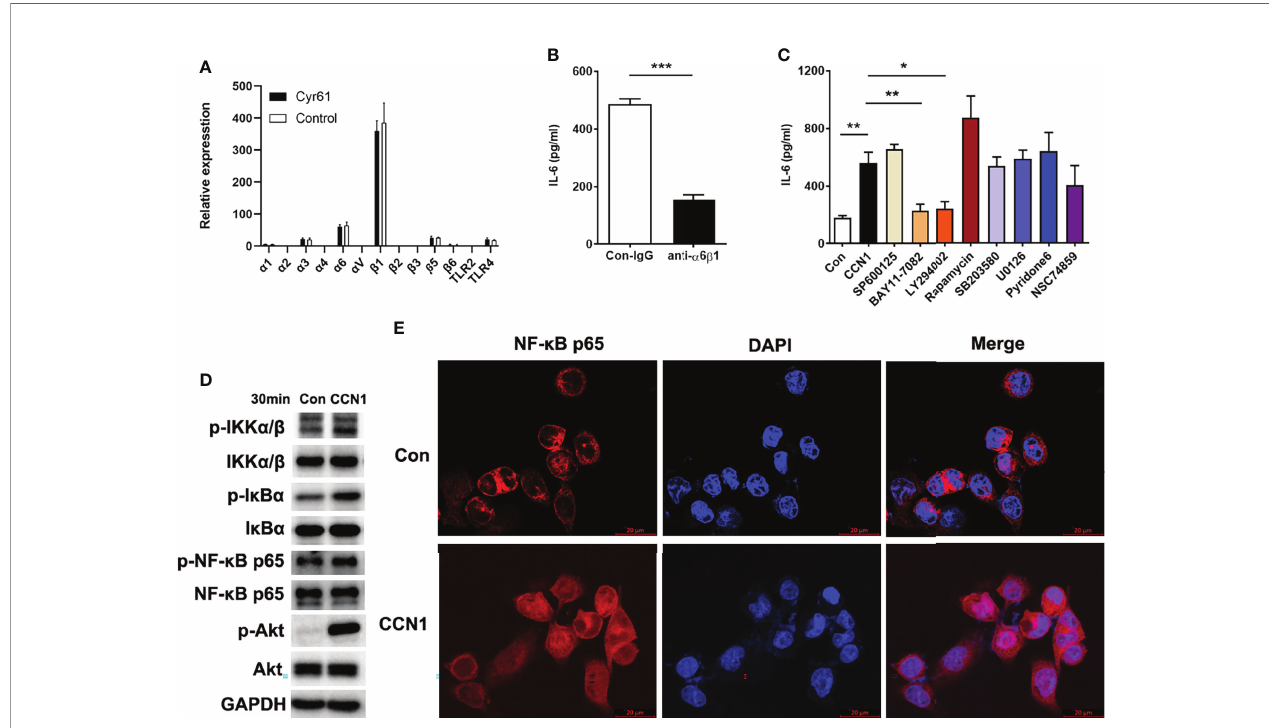
FIGURE 7 | Signaling pathways involved in IL-6 production regulated by CCN1 in LO2 cells. (A) Expression of integrins and TLR2/4 in LO2 cells treated with CCN1 or BSA control was determined by real-time PCR. (B) Inhibition of CCN1-stimulated IL-6 production by anti- a 6 b 1 mAb. CCN1 protein (5 m g/ml) and anti- a 6 b 1 Ab (20 m g/ml) were premix for 20 min, and then the mixtures were added to LO2 cells culture system for another 24 (h) The culture supernatant was collected for detection of IL-6 protein. (C) Inhibitors of signaling pathways on CCN1-induced IL-6 production. LO2 cells were treated with SP600125 (inhibitor of JNK), BAY11- 7082 (inhibitor of NF-kB activation), LY294002 (inhibitor of PI3K), SB203580 (inhibitor of p38 MAPK), U0126 (inhibitor of MEK), Pyridone6 (inhibitor of JAK) and NSC74859 (inhibitor of STAT) for 24 (h) The culture supernatant was collected for detection of IL-6. (D) Phosphorylation of IKK a / b , I k B a , NF- k B p65 and Akt was detected by Western blot. LO2 cells were stimulated with CCN1 (5 mg/ml) for 30 min. (E) Nuclear translocation of NF- k B p65 was monitored by laser confocal fl uorescence microscopy. Top panels, Unstimulated LO2. Bottom panels, Stimulated with CCN1 (5 mg/ml) for 60 min. NF- k B was detected by PE – anti-p65 (red). Nuclei were stained with DAPI (blue). Merged picture shows NF- k B translocation into the nucleus. Original magni fi cation ×400. *p<0.05, **p<0.01, ***p<0.001. All experiments were independently repeated at least three times in